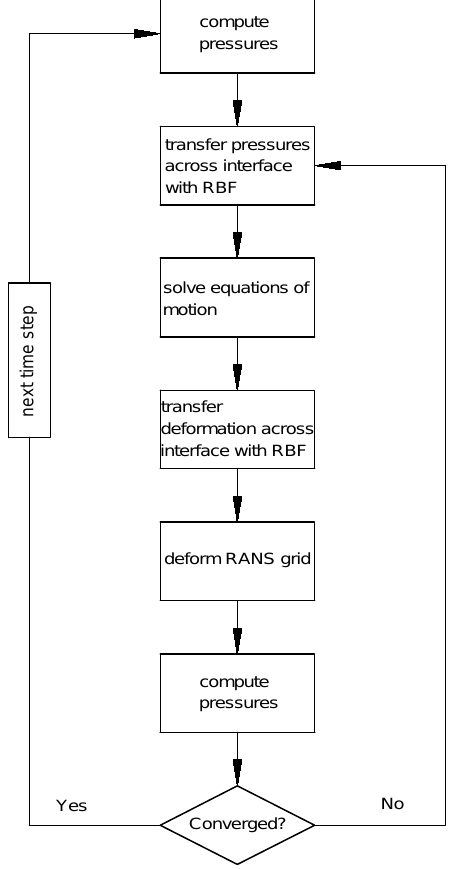
Figure 4. Flow chart of one time step with RANS-FEM